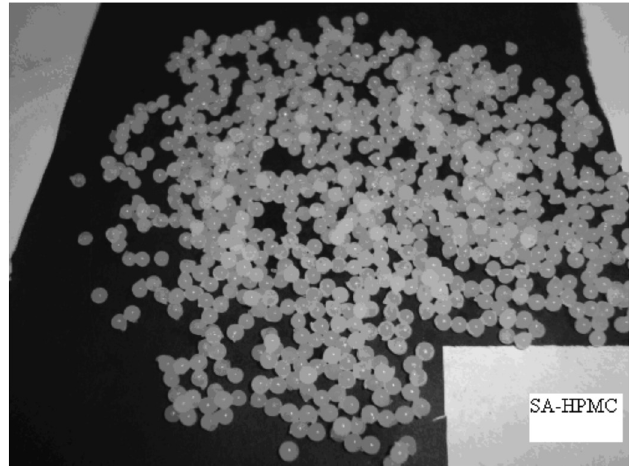
FIGURE 2- Spherical shape of beads prepared with